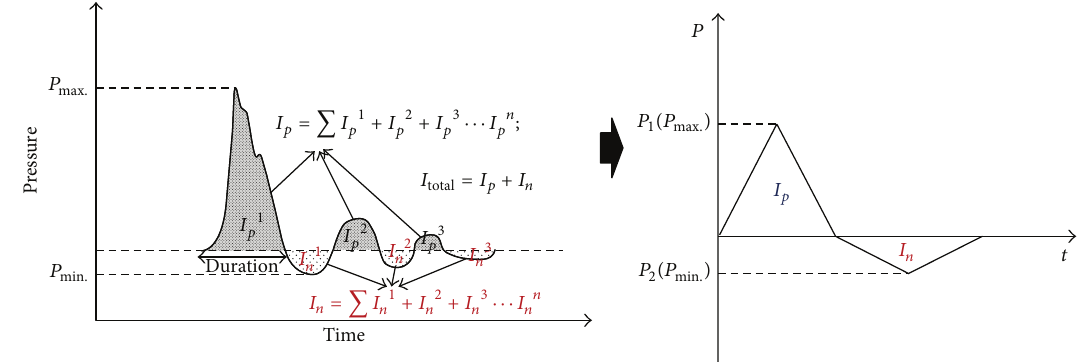
Figure 9: Loading condition of single degree of freedom.